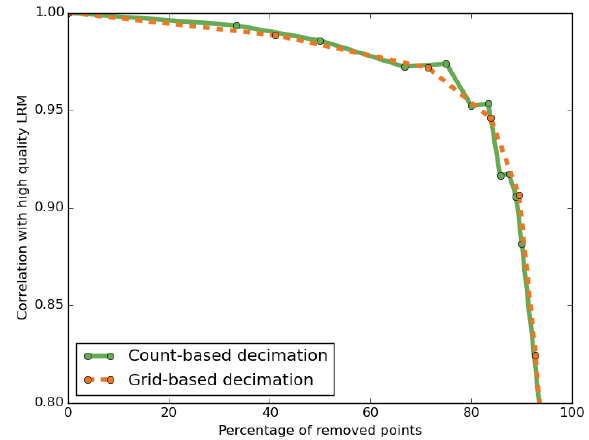
Figure 11: Comparison of performance of count-based and grid-based decimation applied to a point cloud obtained using the Kinect